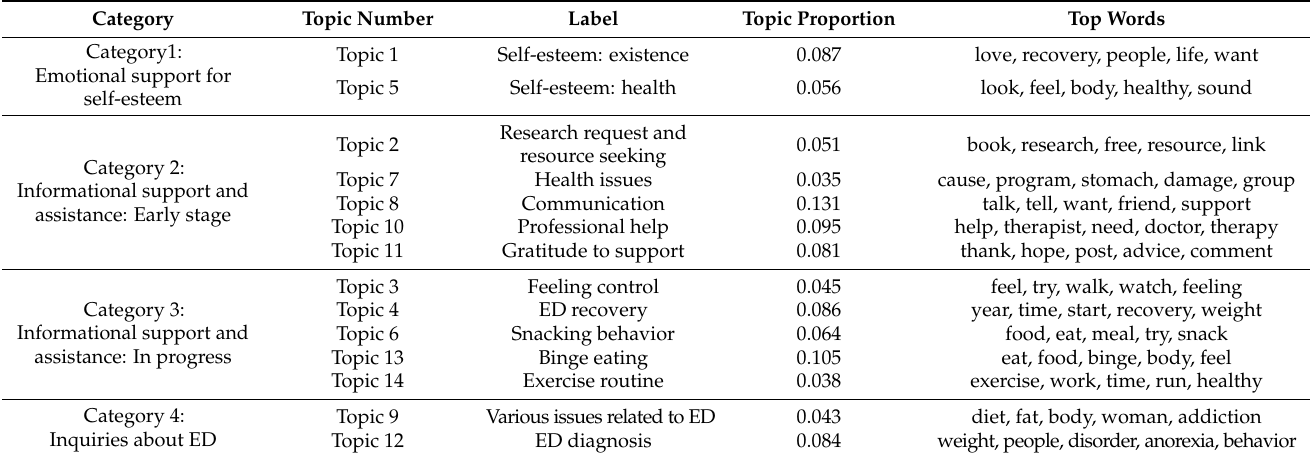
Table 2. Summary of topics in the ED online